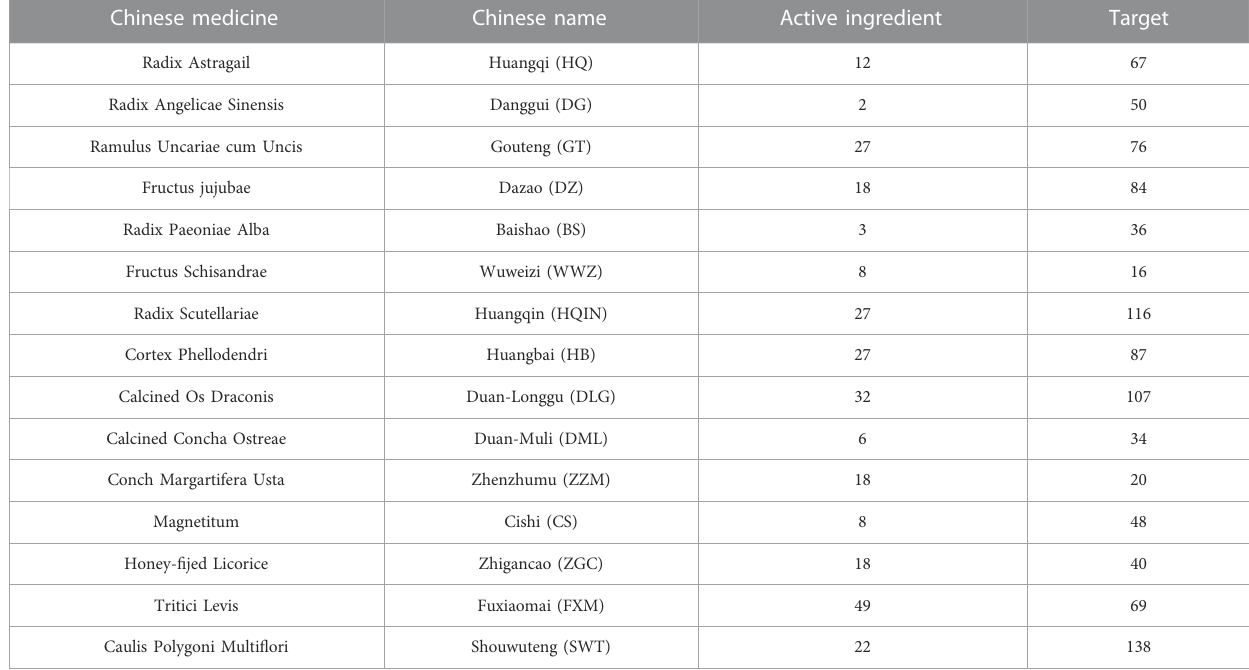
TABLE 3 The number of active ingredients and related targets of LMQXM. Chinese medicine Chinese name Active